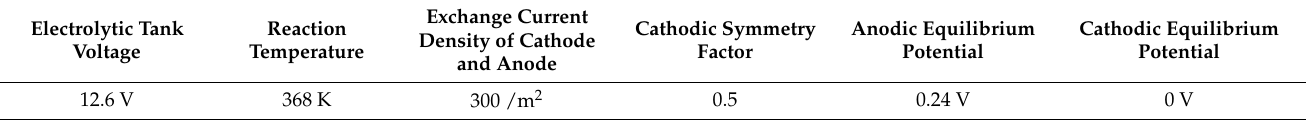
Figure 5. Electrolysis tank model: ( a ) without brush plate; ( b ) with brush plate. Table 1. Cathode and anode boundary.